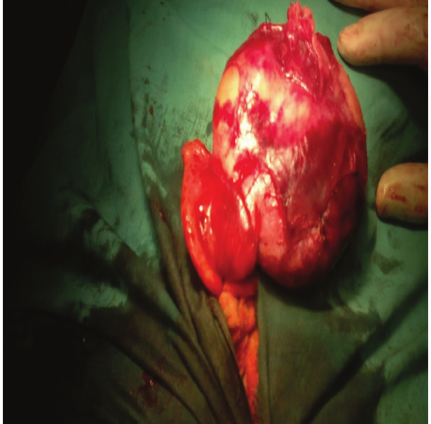
Figure 3: Exploratory laparotomy showing right tuboovarian mass.